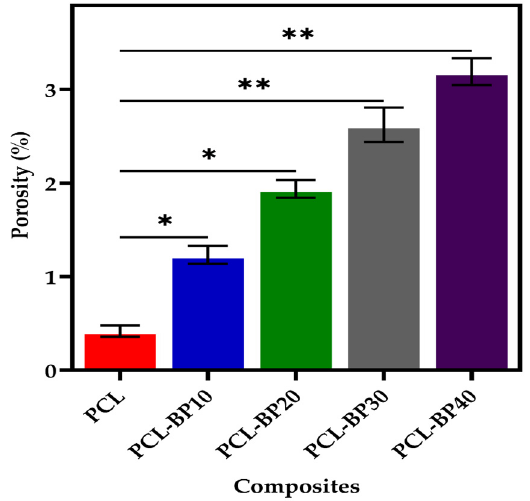
Figure 4. The porosity of PCL and PCL-BP composites ( n = 3, * p ≤ 0.05, ** p ≤ 0.01).